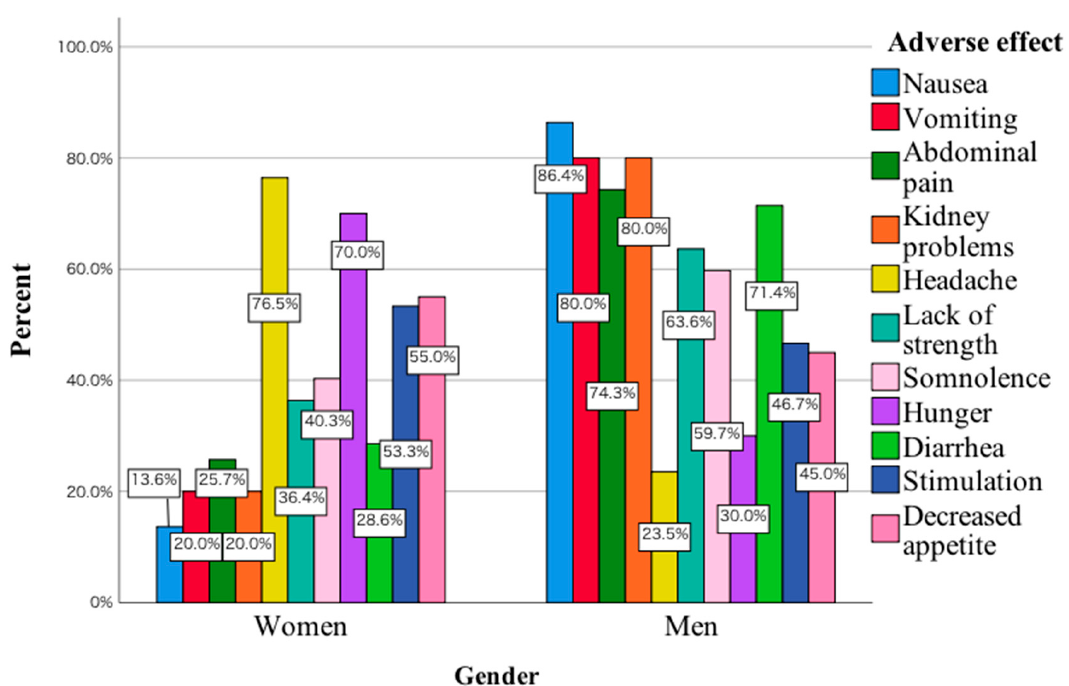
Figure 3. Adverse effects related to the consumption of Amanita muscaria in the study group women and and men.